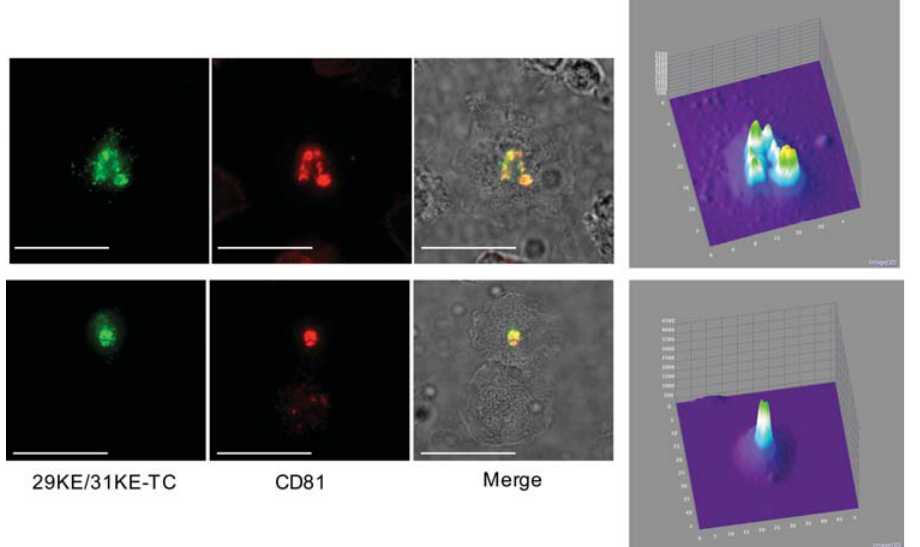
Figure 8. Gag recruitment to the synapse in MDMs is blocked by the 29KE/31KE MA mutations. MDMs were infected with VSV-G- pseudotyped NL4-3/29KE/31KE-TC virus, labeled with FlAsH 24–48 hrs postinfection, fixed, and stained with anti-CD81 antibody. Gag/CD81 colocalization is indicated as yellow in merge. Scale bars=30 m m. Far-right panels show distribution of Gag signal; plots were obtained as described in the Fig. 5 legend. Note the centrally located (non-synapse) concentration of Gag in these cells expressing the 29KE/31KE MA mutant.